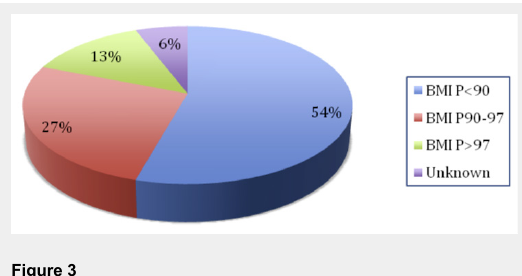
BMI (Body mass index) percentile of patients from 2 to 16 years